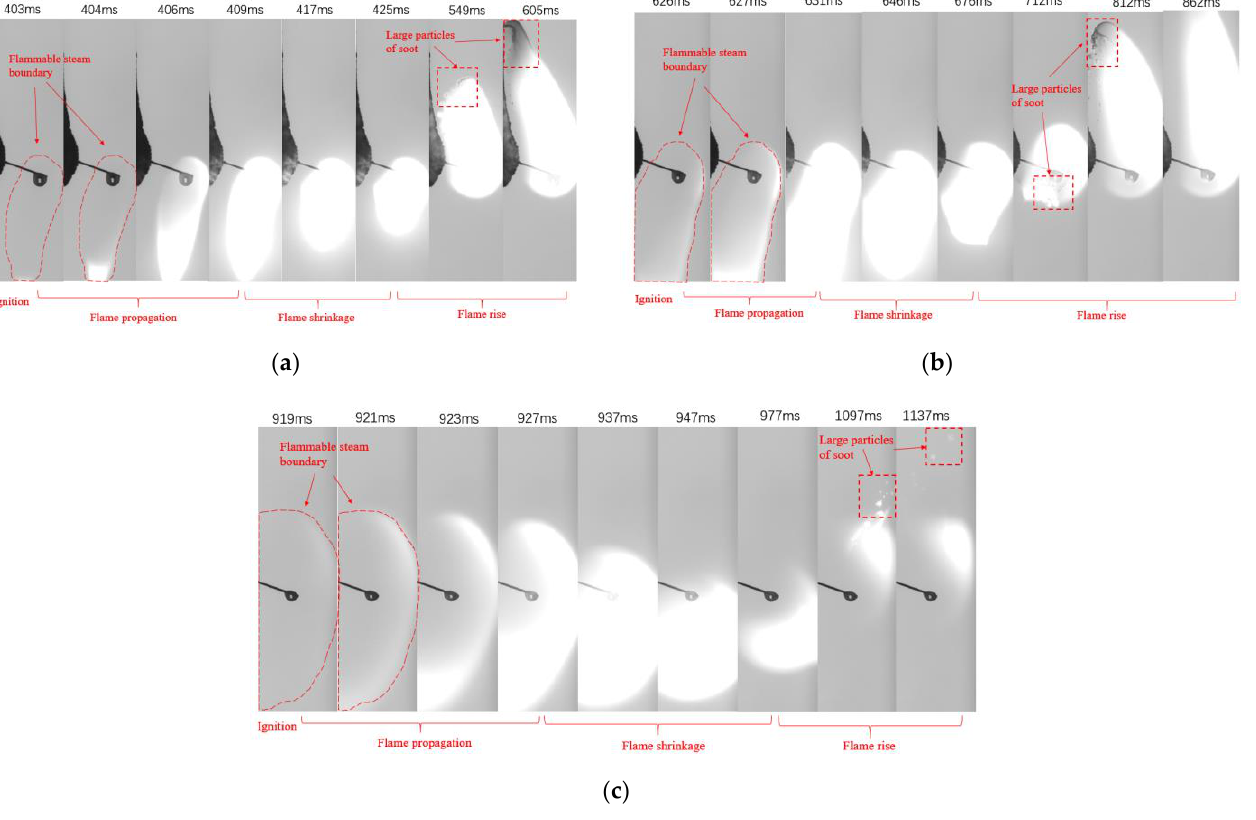
Figure 7. Spontaneous ignition process at 973 K ambient temperature and different pressures: ( a ) 1.0 bar; ( b ) 0.6 bar; ( c ) 0.2 bar.